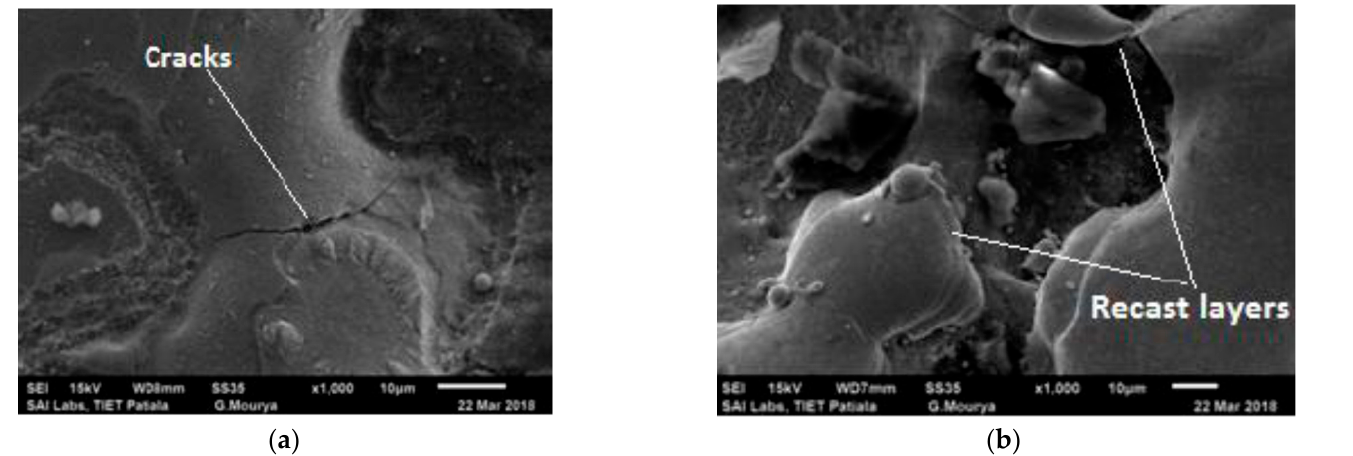
Figure 7. Surface characteristics of the workpiece after EDM ( a ) for Experiment 11 ( b ) for Experiment 2.